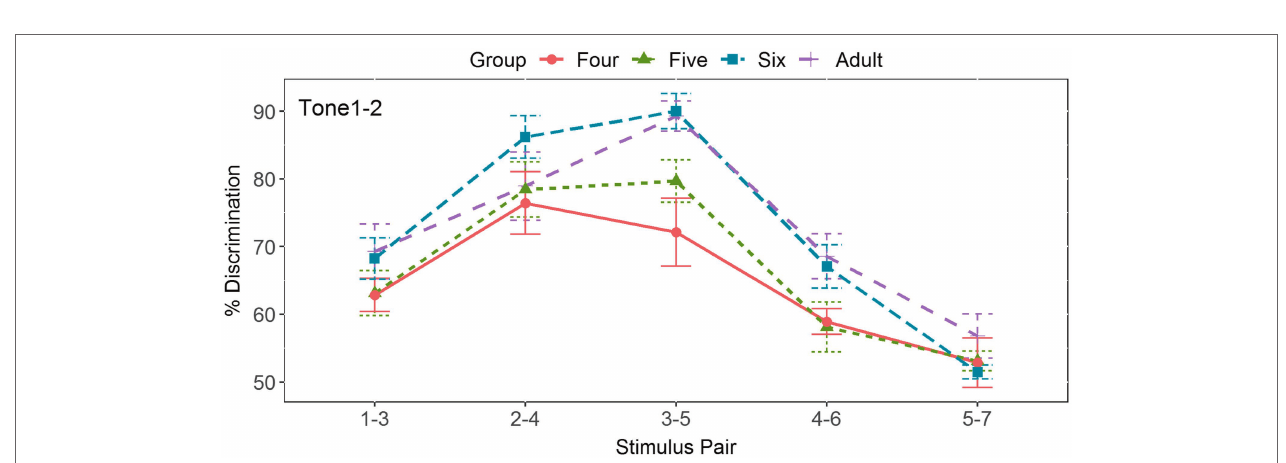
FIGURE 6 | Two-step discrimination scores for the five pairs in the tonal continuum across age